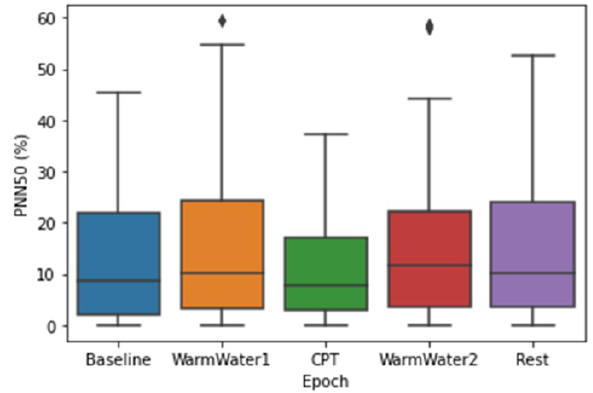
Figure 7. Boxplot of pNN50 values for each epoch. The (cid:5) stands for